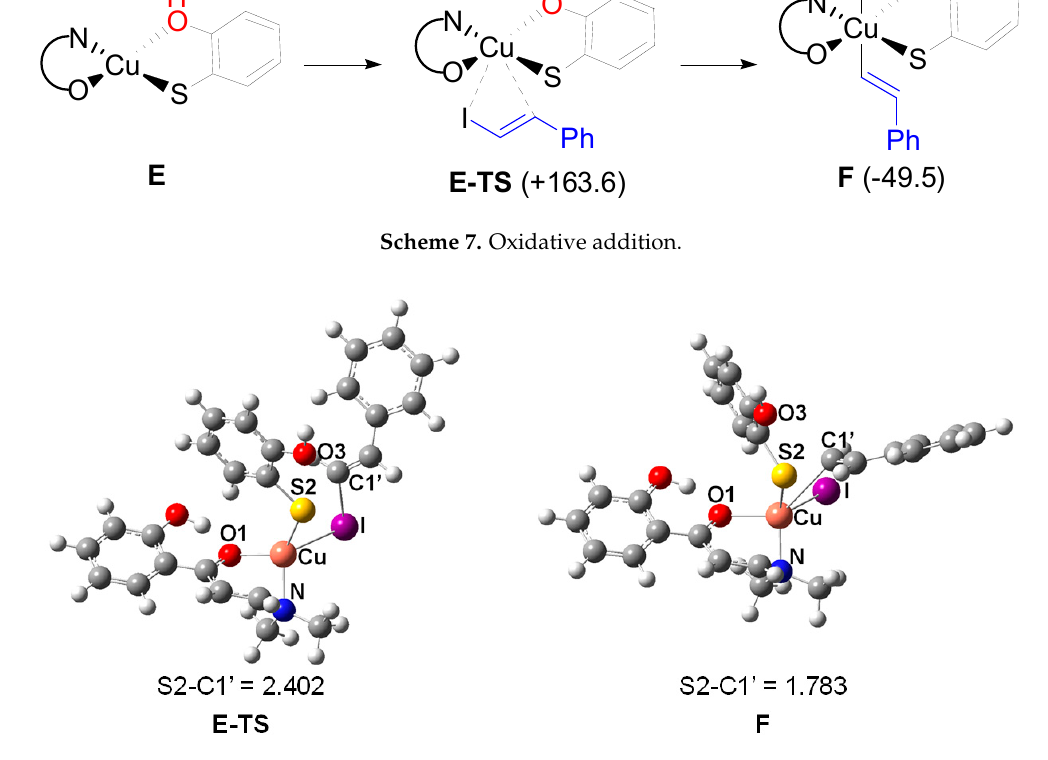
Figure 4. Optimized structures for intermediates E-TS and F .